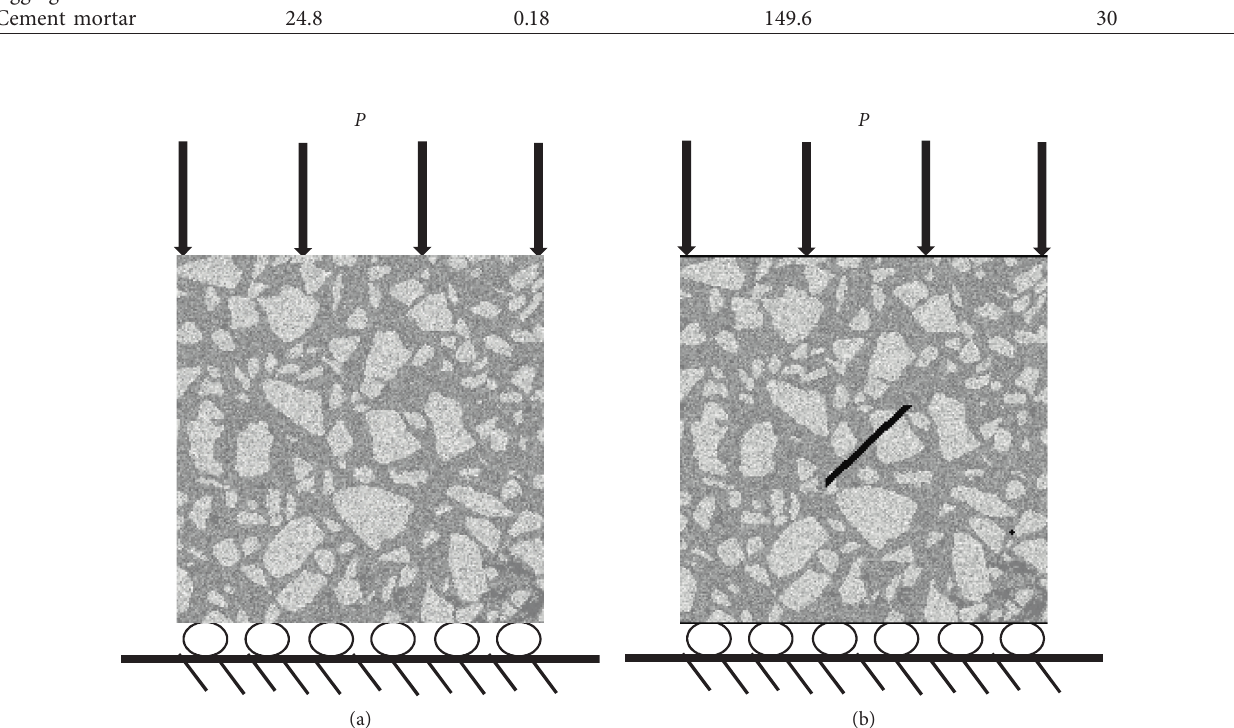
Figure 3: Schematic diagram of numerical model